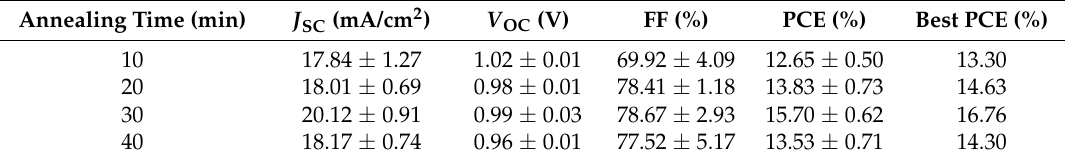
Table 1. Photovoltaic parameters of MA 0.7 FA 0.3 Pb(I 0.9 Br 0.1 ) 3 perovskite solar cells annealed at 100 °C for 10, 20, 30 and 40 min. a